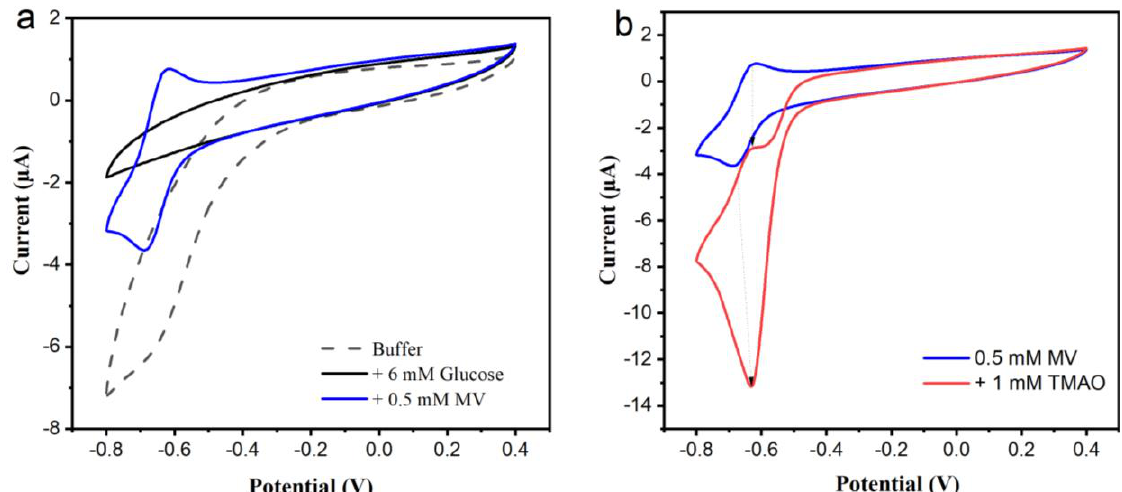
Figure 2. CV of TMAO reductase (TorA)/glucose oxidase (GOD)/catalase (Cat)-modified glassy carbon electrode (GCE) in ( a ) air saturated buffer solution without (dashed line) and with glucose (black line) and ( a , b ) with glucose and methylvio- logen (MV) (blue line) and TMAO (red trace). Measurements were performed in Sörensen phosphate buffer pH 7; TorA 5.9 nmol/cm 2 , GOD 10 U, Cat 1000 U, PVA 3%. Reference electrode: Ag/AgCl/1 M KCl, Scan rate: 5 mV/s.